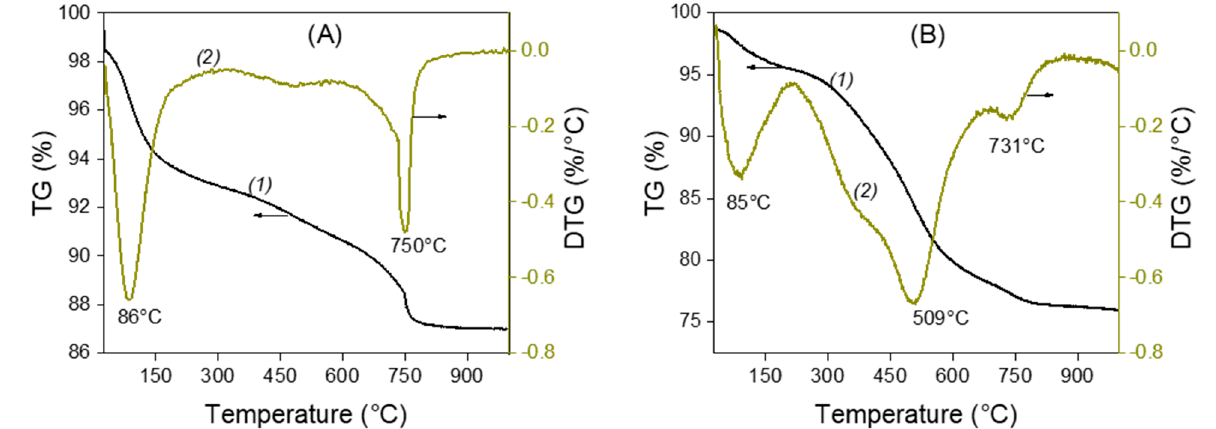
Figure 2. Thermogravimetric analysis (curves 1) and differential thermal gravimetry (curves 2) curves of unmodified La ( A ) and amino-functionalized laponite LaNH 2 ( B ).